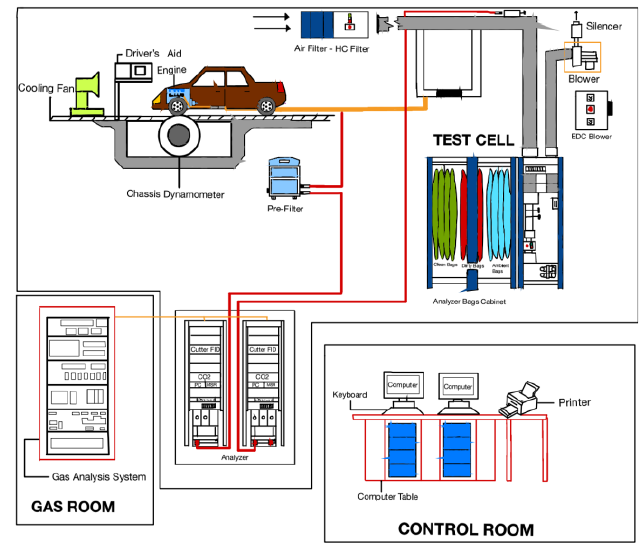
Figure 1. The light-duty vehicle test system. (Adopted from [24]).